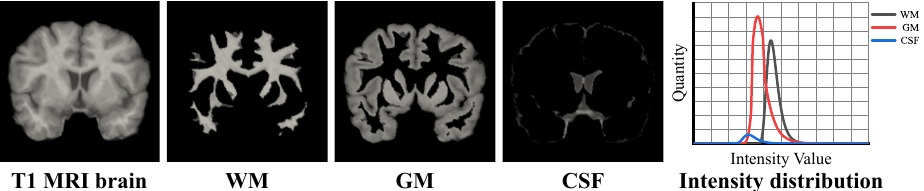
Figure 1. A T1 MRI human brain image, tissue segmentation, and corresponding intensity distribu- tions are